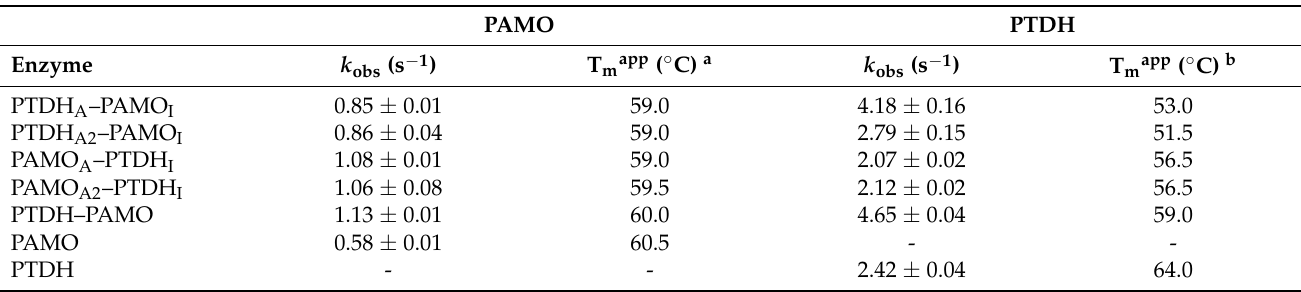
Table 2. Activity and stability of enzymes and enzyme complexes. PAMO